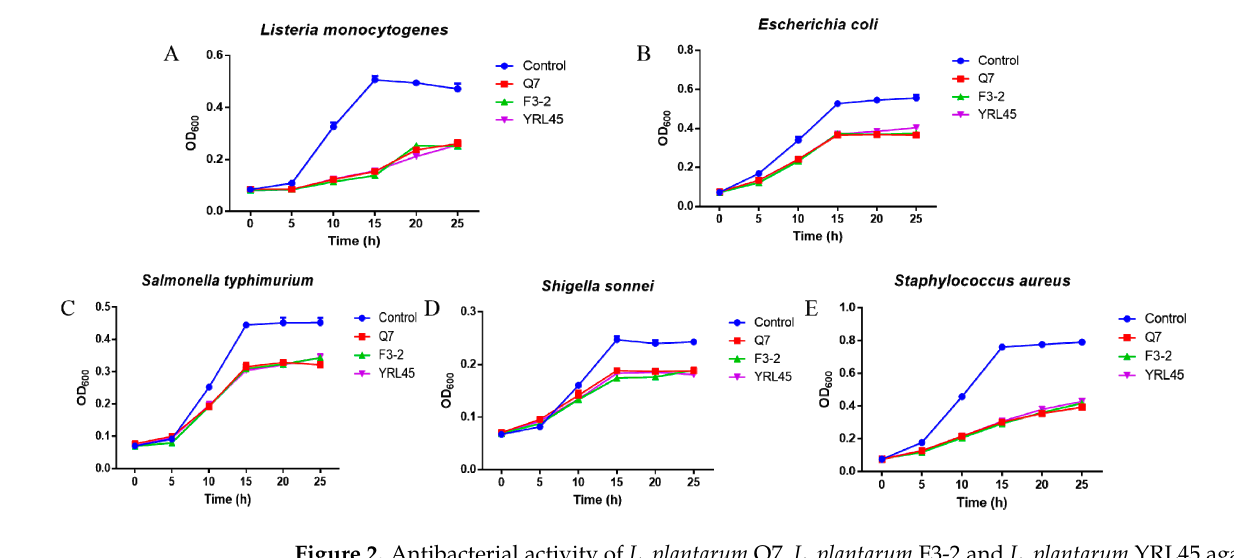
Figure 2. Antibacterial activity of L. plantarum Q7, L. plantarum F3-2 and L. plantarum YRL45 against L. monocytogenes ( A ), E. coli ( B ), S. typhimurium ( C ), S. sonnei ( D ) and S. aureus ( E ). Table 4. Acid and bile salt tolerance of L. plantarum Q7, L. plantarum F3-2 and L. plantarum YRL45.